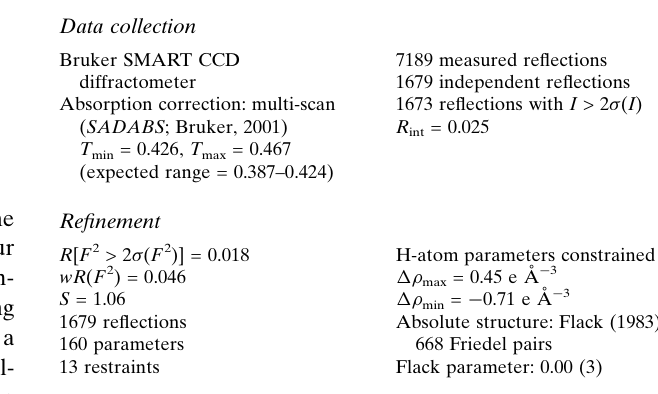
Key indicators: single-crystal X-ray study; T = 293 K; mean (cid:1) (C–C) = 0.006 A˚; disorder in solvent or counterion; R factor = 0.018; wR factor = 0.046; data-to- parameter ratio = 10.5.